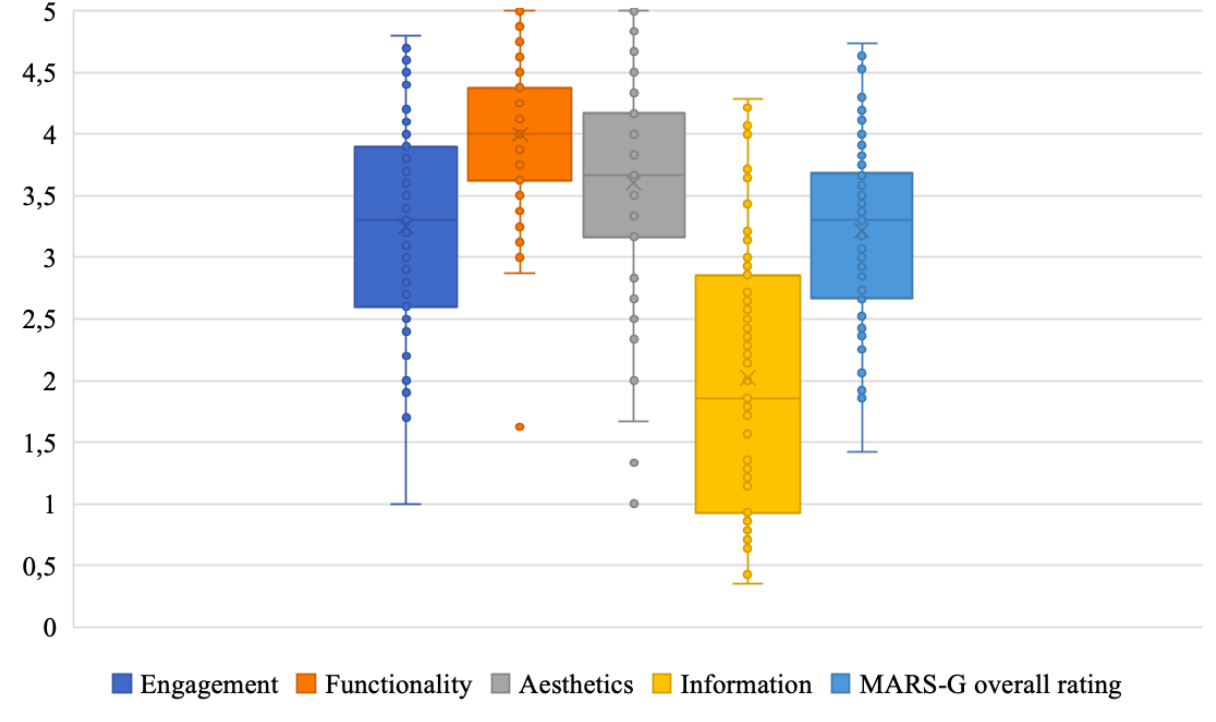
Figure 4. Graphical representation of the distribution of the Mobile Application Rating Scale (German version) overall rating, and the four subdimensions. The median, the interquartile distance as well as the range and outliners were given (n=83 mobile apps).